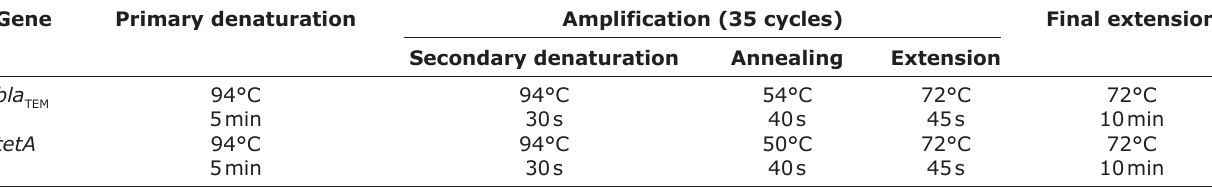
and tetA genes. TEM